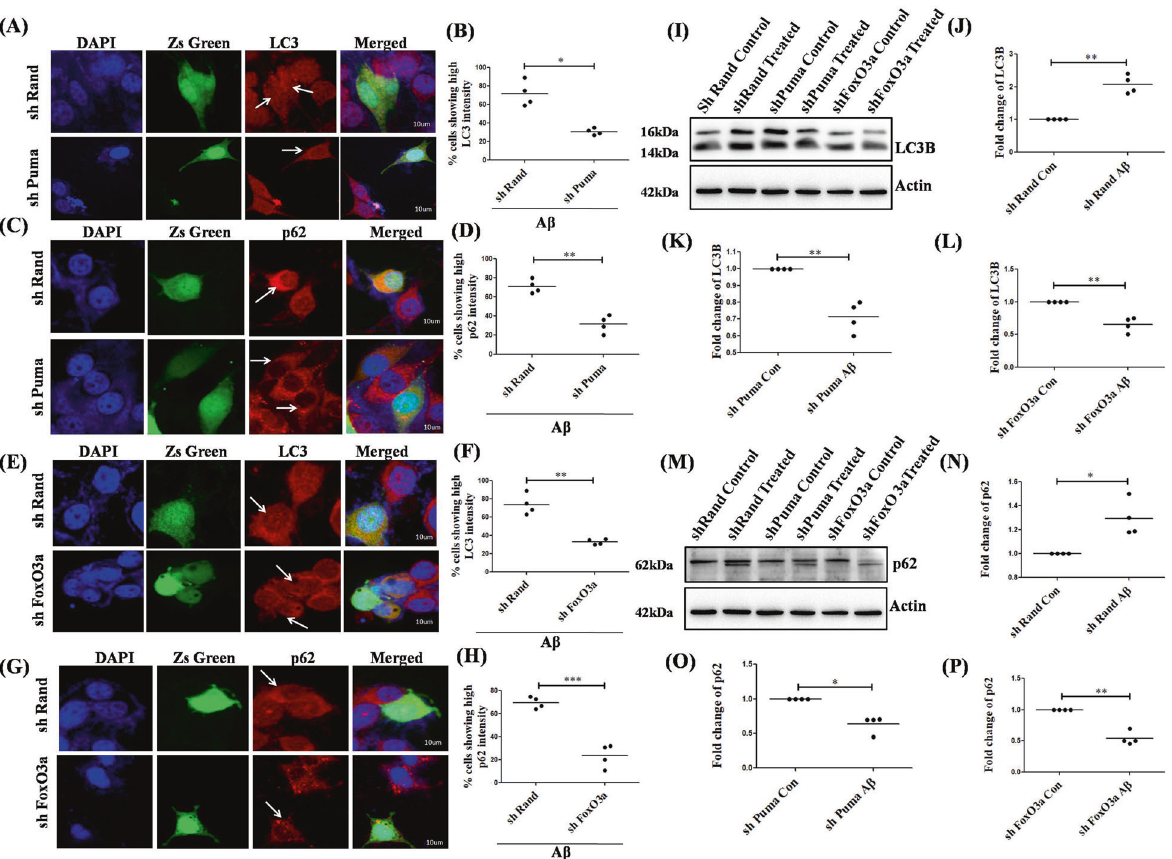
Fig. 5 Puma and FoxO3a trigger autophagy initiation but interferes in autophagy fl ux upon A β toxicity. Naïve PC12 cells were transfected with shPuma-ZsGreen (green) or shRand-ZsGreen (green), primed, and then treated with 5 µM A β for overnight after which they were immunostained with ( A ) anti-LC3B antibody (red) and ( C ) anti-p62 antibody (red). Nuclei were stained with DAPI. Images were taken under a confocal microscope. Scale bars: 10 µm. ( B ) and ( D ) Graphical representation of the percentage of cells showing the high intensity of LC3B and p62 respectively under Puma compromised conditions. Data represented were collected from of 4 independent experiments. Naïve PC12 cells were transfected with shFoxO3a-ZsGreen (green) or shRand-ZsGreen (green), primed, and then treated with 5 µM A β for overnight after which they were immunostained with ( E ) anti-LC3B antibody (red) and ( G ) anti-p62 antibody (red). Nuclei were stained with DAPI. Images were taken under a confocal microscope. Scale bars: 10 µm. ( F ) and ( H ) Graphical representation of the percentage of cells showing the high intensity of LC3B and p62 respectively under FoxO3a compromised conditions. Data represented were collected from 4 independent experiments. Naïve PC12 cells were transfected with shPuma or shFoxO3a or shRand, primed, and then treated with 5 µM A β for overnight, and whole-cell lysates were assessed by western blot for protein levels of ( I ) LC3B and ( M ) p62 respectively. ( J ), ( K ) and ( L ) Graphical representation of the fold change of LC3B under A β toxicity in control, Puma downregulation, and FoxO3a downregulation respectively. Data represented were collected from 4 independent experiments. ( N ), ( O ), ( P ) Graphical representation of the fold change of p62 under A β toxicity in control, Puma downregulation, and FoxO3a downregulation respectively. Data represented were collected from 4 independent experiments. The asterisks denote statistically signi fi cant differences from control (shRand) at corresponding conditions; * p < 0.05, ** p < 0.001, *** p <